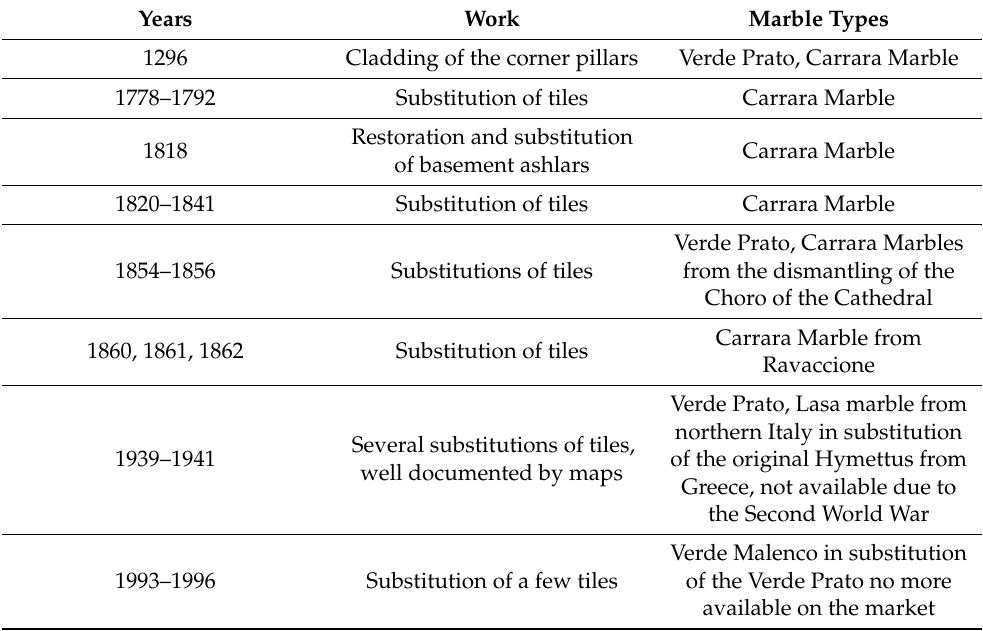
Table 1. Documented substitutions for the cladding stone elements of the